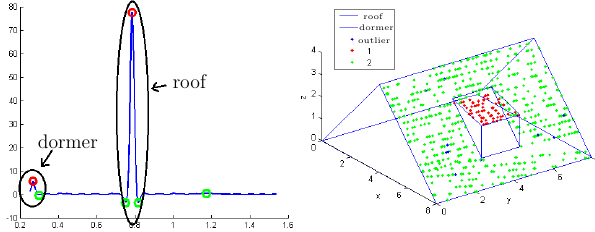
Figure 9. 3D point cloud of a roof colored according to the incli- nation of the points. Roof points (green) and shed dormer points (red). The PDF of the inclination gives insight into the object